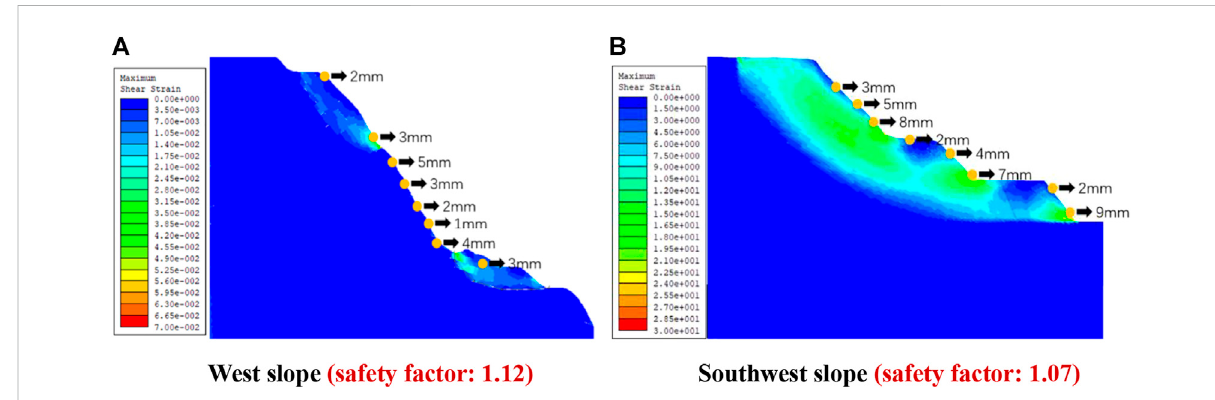
FIGURE 7 The potential landslide simulation. (A) West slope (safety factor: 1.12); (B) Southwest slope (safety factor: 1.07).